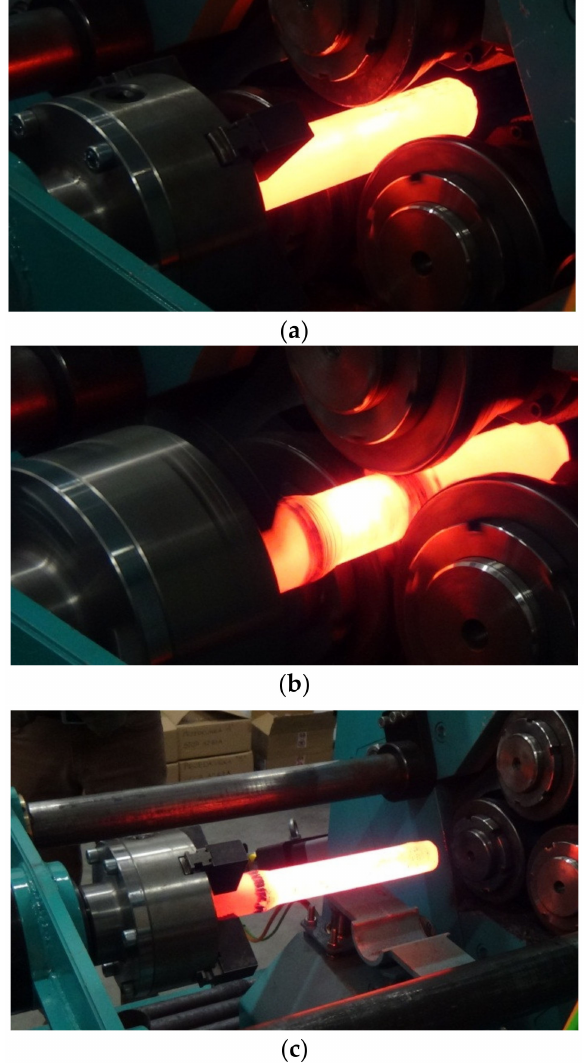
Figure 5. Stages of skew rolling of a bimetallic rod: ( a ) the billet is fed between the rotating tools; ( b ) rolling; ( c ) the rolled part is removed from the tool working